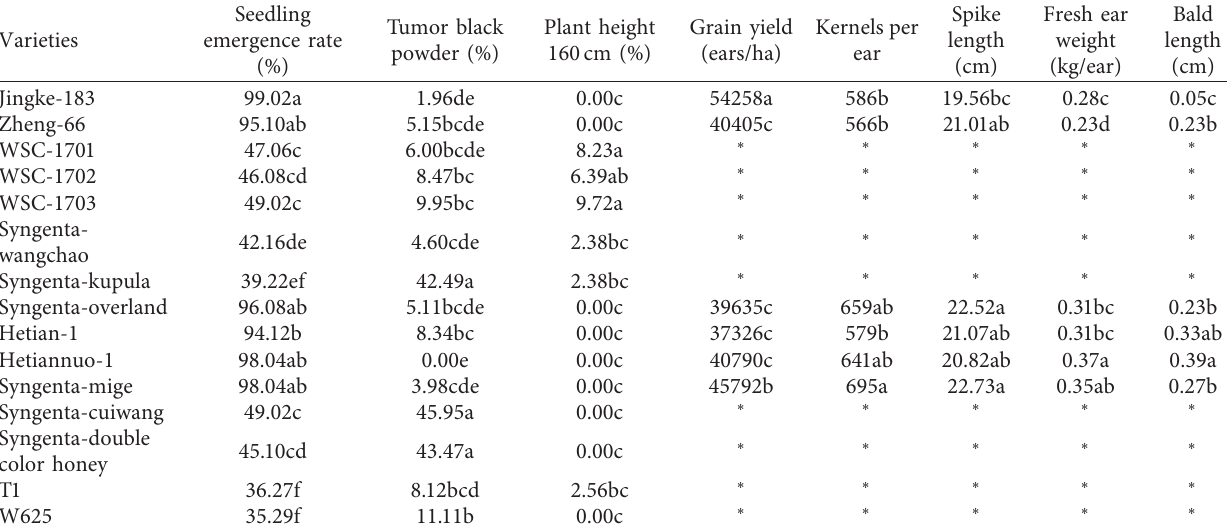
Table 3: Growth and yield of sweet maize during